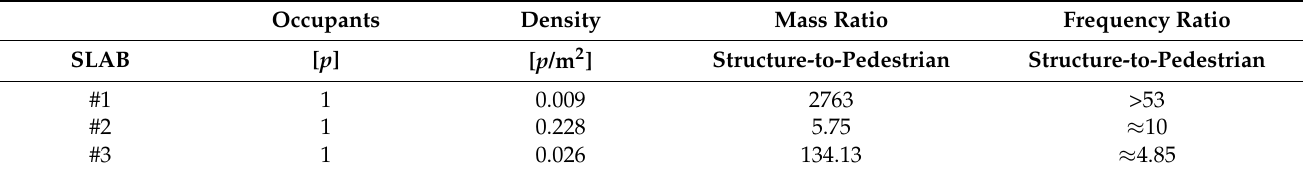
Table 3. Summary of reference parameters for normal walking experimental measurements (with p = 1, f p ≈ 1.5 Hz and M p = 80 kg).